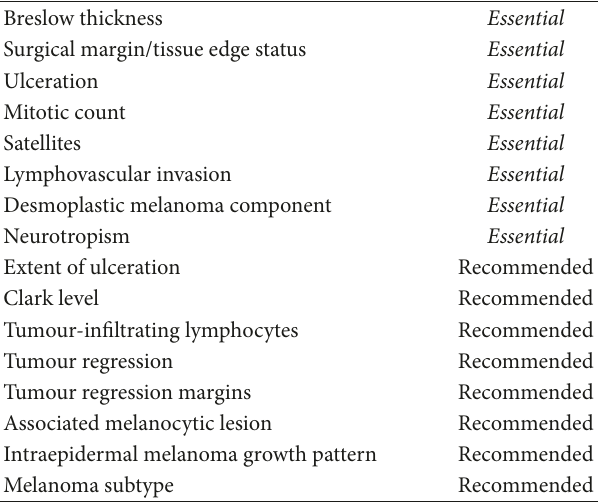
Table 1: Essential and recommended elements of structured micro- scopichistopathologicalreportingforprimarycutaneousmelanoma espoused by the International Collaboration on Cancer Reporting (ICCR)